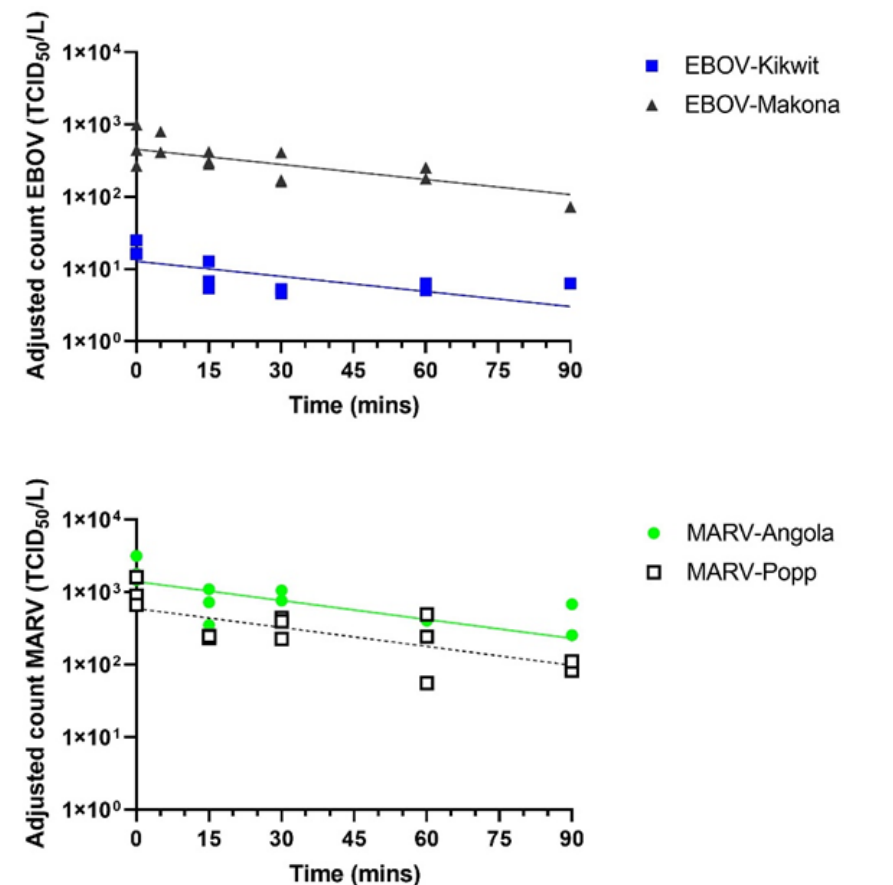
Figure 1. Aerosol survival of different variants of EBOV and MARV. Filoviruses were aerosolized and held as a dynamic aerosol in the Goldberg drum. Impinger samples were taken at various time-points and enumerated for viable viruses by TCID 50 assay in triplicate. Each virus was assessed on three separate occasions. Graphs show the adjusted mean count for each run (as individual data points) for two EBOV variants ( top ) and for two MARV variants ( bottom ). Best fit lines were fitted to the data using linear modeling.